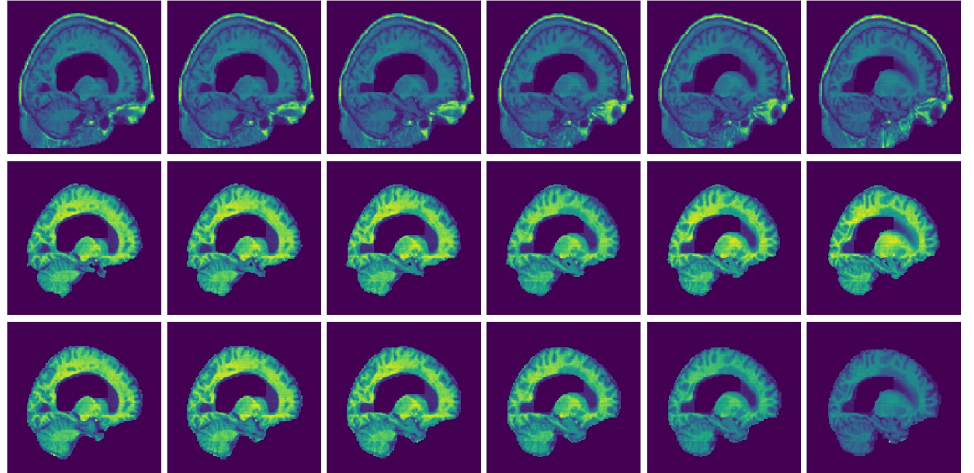
Figure 10. Selected MRI slices (OASIS data set): Sagittal MRI plane segmented brain. Row one: Input images, Row two: Predicted brain and Row three: Ground truth